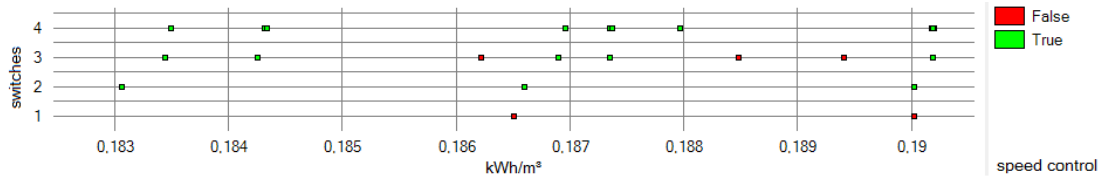
Figure 6. Comparison to speed control. Red solutions operate pumps at nominal speed. Green solutions operate pumps with a speed of